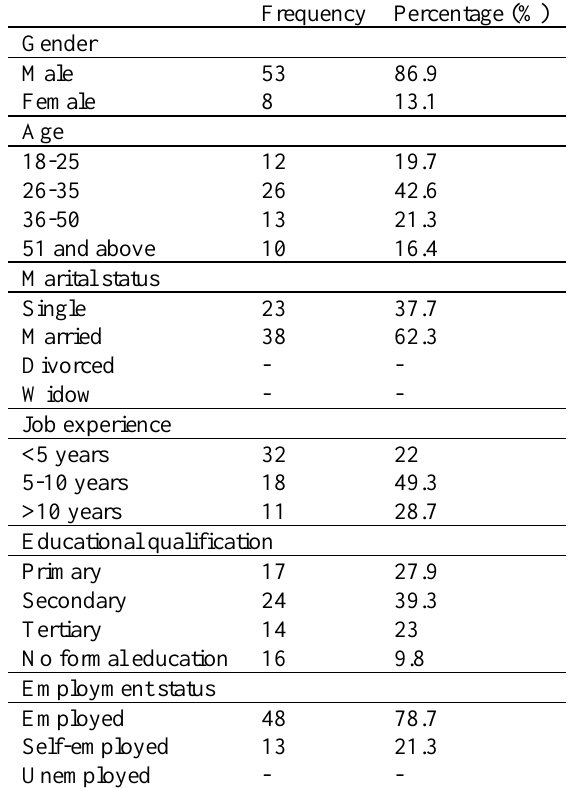
Table 2. Sociodemographic data of respondents